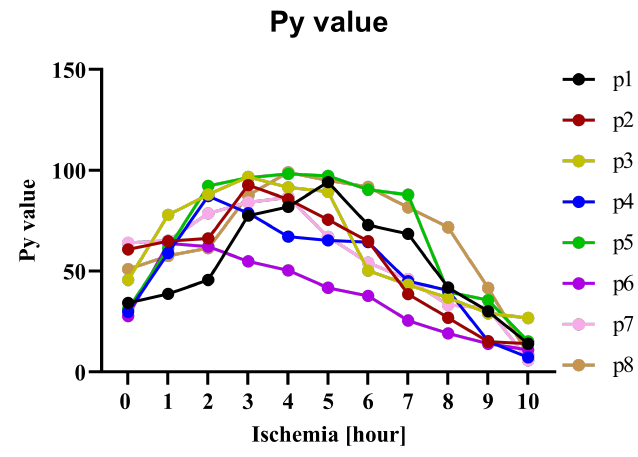
Figure 4: Plot of calculated P value for eight small y intestine samples from different patients. P y values from the fitting procedure for eight intestine samples. The P value first increased then decreased with y time. For almost all samples, the P value reached y